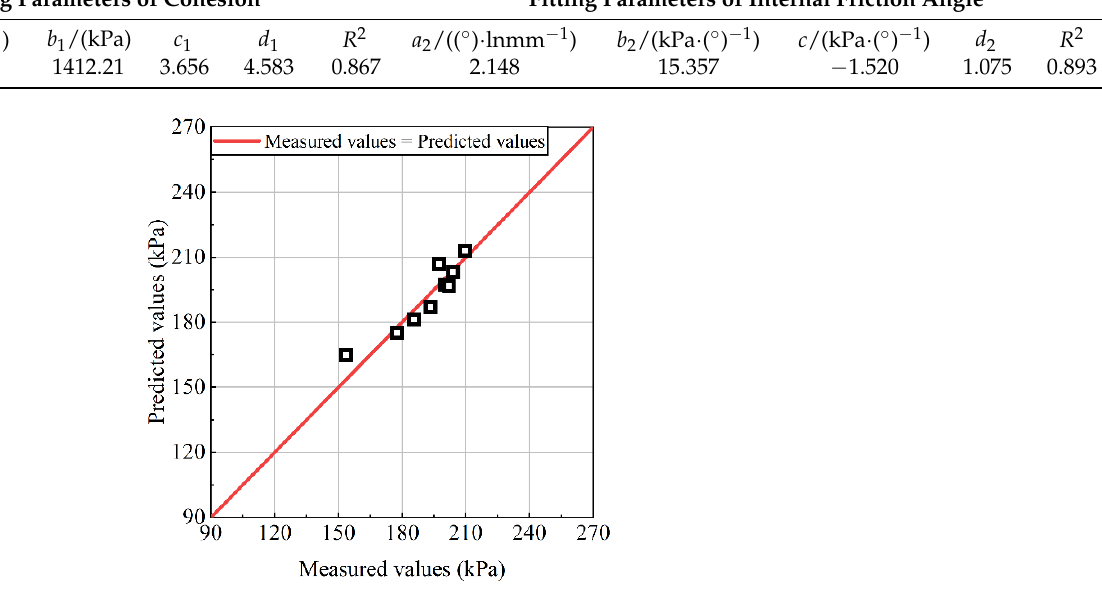
Figure 15. Measured and predicted values of the cohesion angle of rockfill materials.